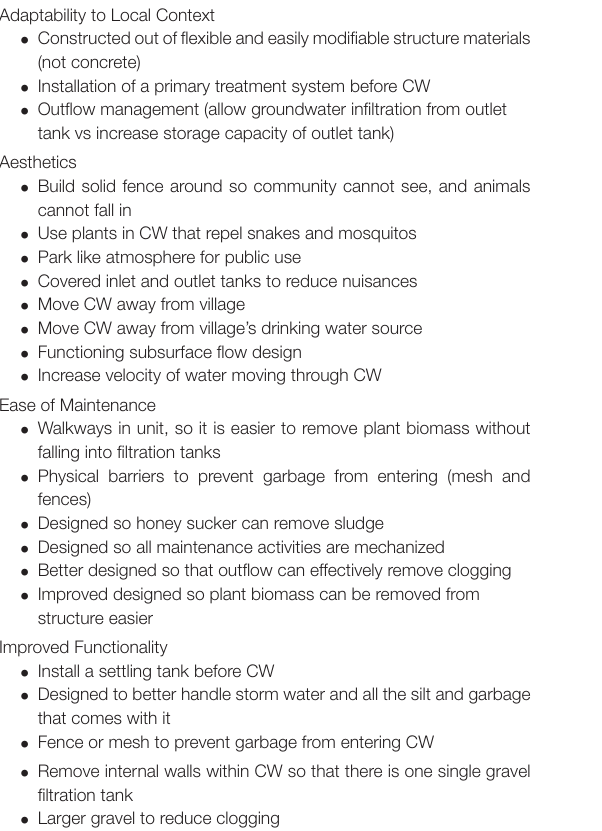
TABLE 5 | Design suggestions for improving the maintenance and acceptability of the CW within the community. Adaptability to Local Context • Constructed out of flexible and easily modifiable structure